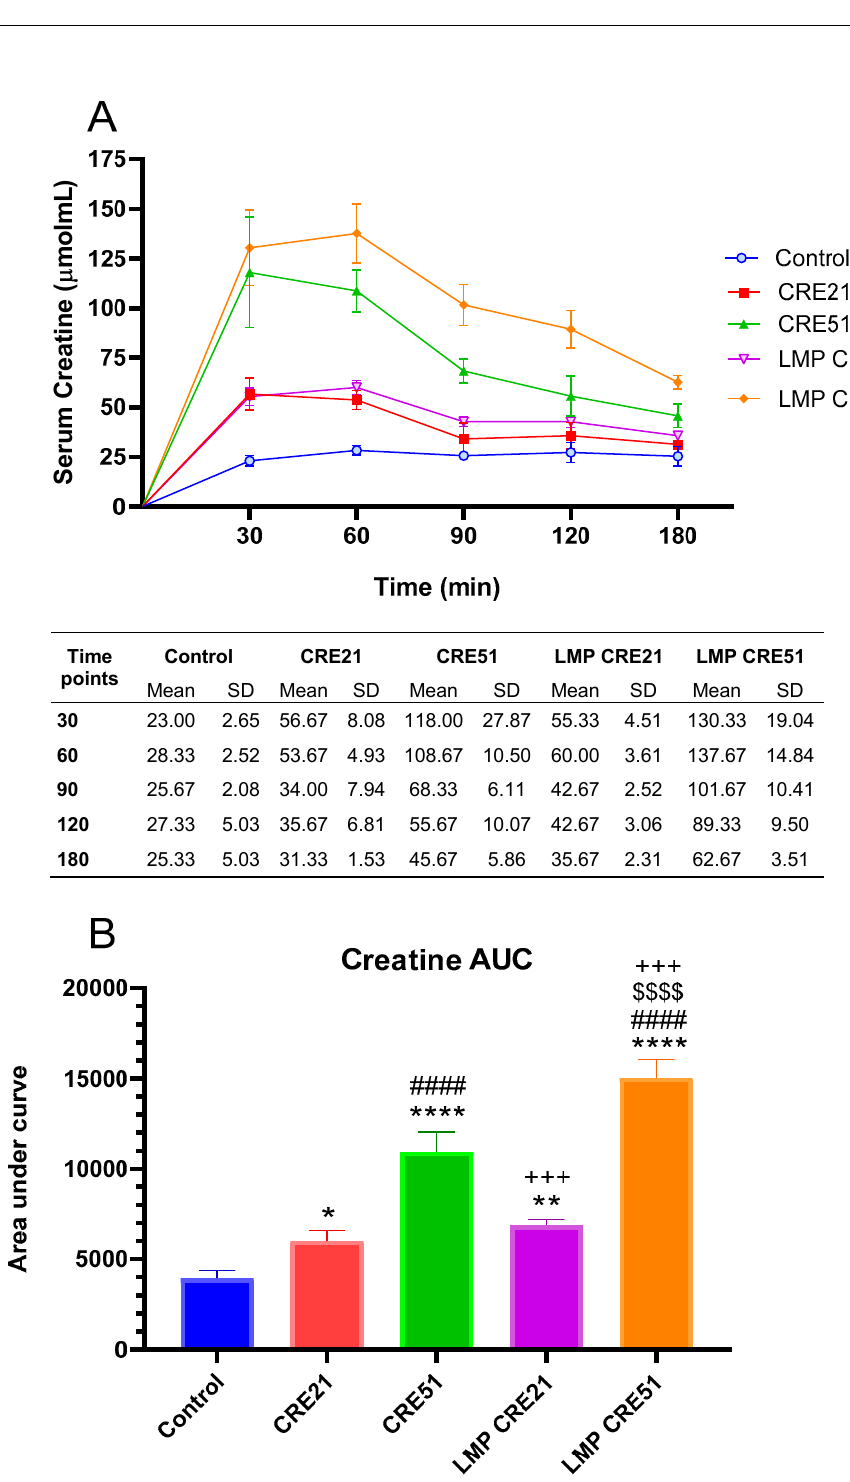
Figure 3. Effect of LMP formulation on serum creatine concentration in rodents. Serum creatine concentration following oral administration at 21 mg/kg (CRE21) or 51 mg/kg (CRE51) ( n = 7) without or with LMP (LMP CRE21 and LMP CRE51, respectively) in rat sera ( A ). Area Under Curve (AUC) for creatine with or without LMP in rat sera ( B ). The error bars correspond to the standard deviation of the mean. In Panel B, ANOVA and the Tukey post-hoc test were used for comparing the results among different treatment groups. Statistical significance between groups is shown by * p < 0.05; ** p < 0.01; **** p < 0.0001 as compared to control group, #### p < 0.0001 as compared to CRE 21 group, +++ p < 0.001 as compared to CRE 51 group, and $$$$ p < 0.0001 as compared to LMP CRE 21 group.